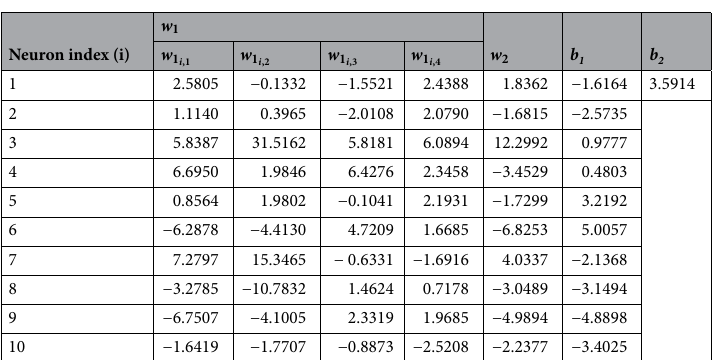
Table 5. Extracted weights and biases for the empirical